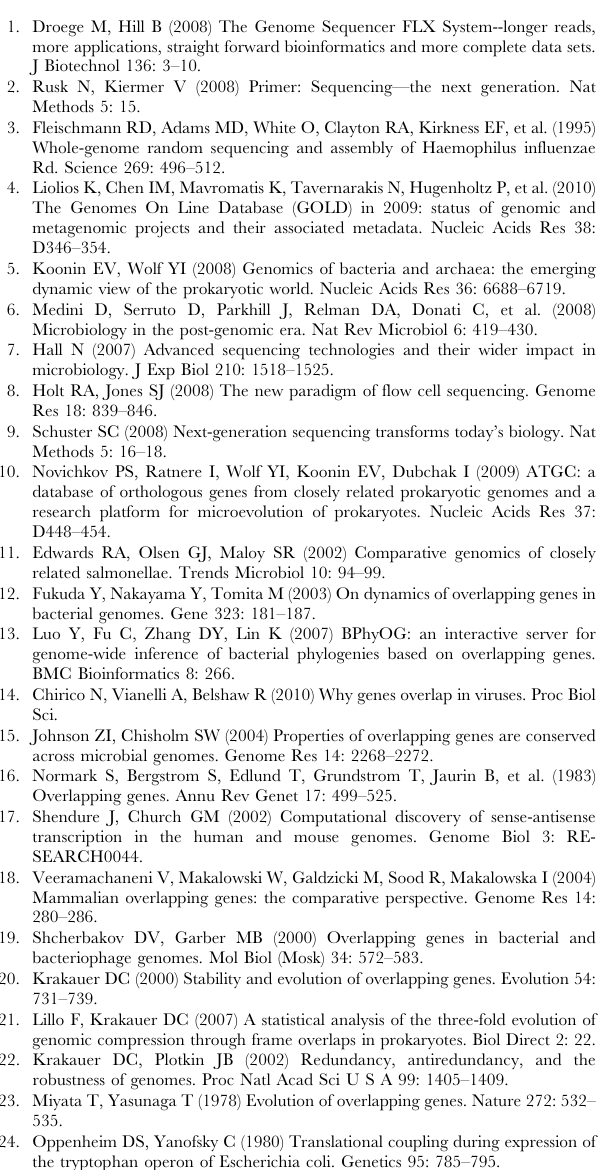
Figure S1 The ML tree inferred from the four-fold degenerate sites of 474 genes with 100 bootstrap replicates. Figure S2 The NJ tree inferred from the four-fold degenerate sites of 474 genes with 100 bootstrap replicates. Figure S3 The Bayesian tree inferred from the four-fold degenerate sites of 474 genes with 100 bootstrap replicates.